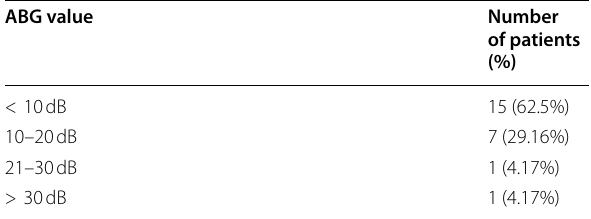
Table 2 Post-operative air-bone gap at the end of 3rd